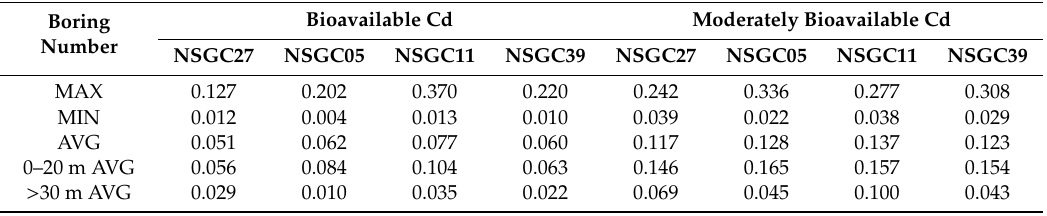
Table 5. Descriptive statistics of bioavailable and moderately bioavailable Cd in each